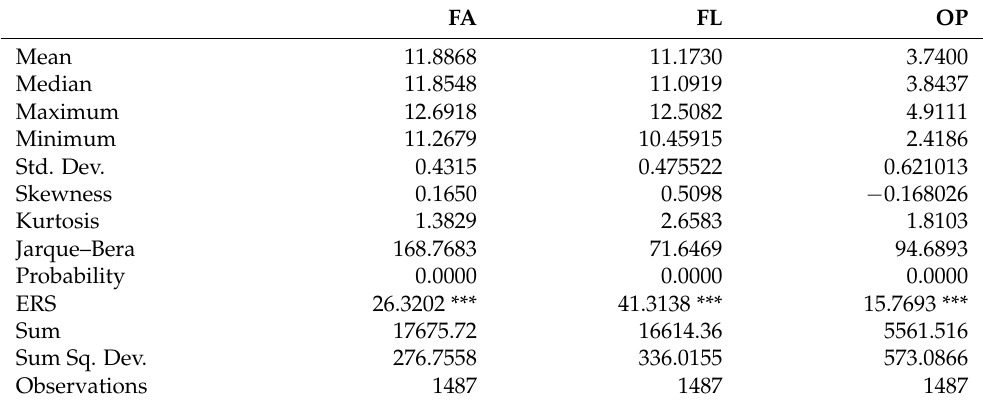
Table 2. Descriptive